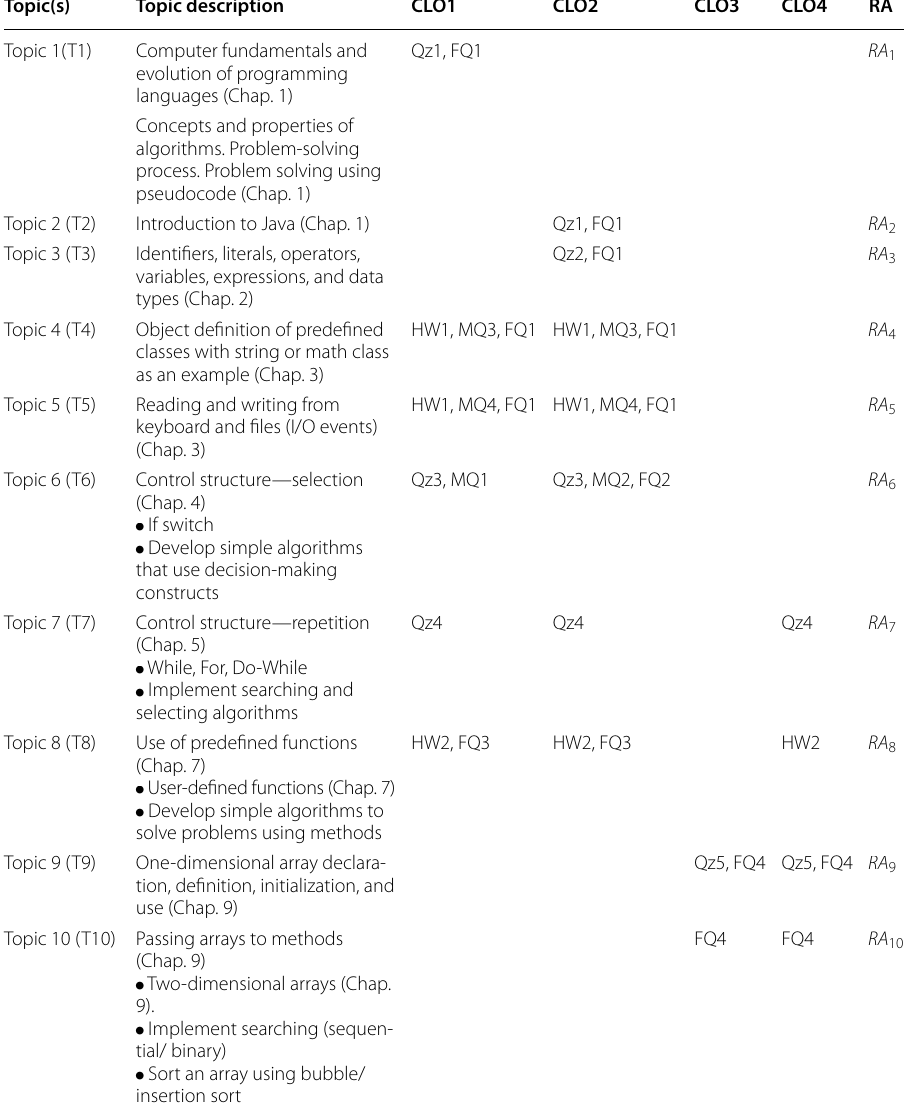
Table 7 Contribution of assessments to topics and